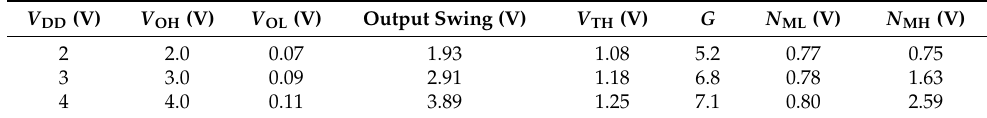
Figure 7. The static voltage transfer characteristics of the inverter with α = 15 measured at supply voltage V DD = 2, 3, 4 V. Table 2. Noise margins for inverters with different V DD with α = 15.